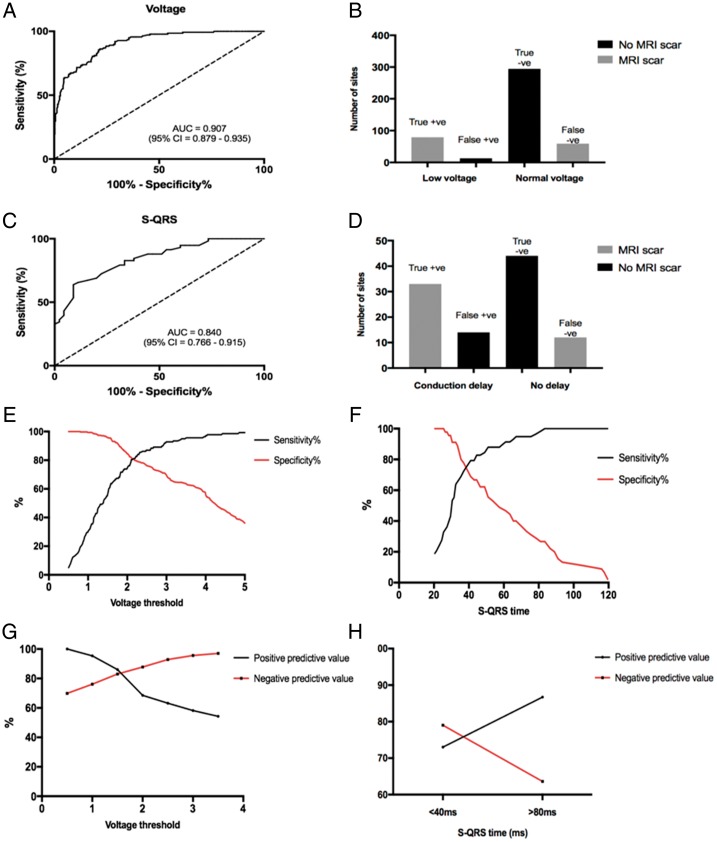
ROC curves (A and C) for prediction of LGE regions using voltage mapping and S-QRS. Frequency histograms (B and D) displaying the true positive, false positive, true negative, and false negative counts of voltage mapping and S-QRS measurements using the real-time MR-EP system to predict MRI-derived scar. Sensitivity, specificity, PPV, and NPV of measurements using the system using different normal voltage cut-offs and S-QRS times (E–H). LGE, late gadolinium enhancement; MR-EP, magnetic resonance imaging-guided electrophysiology; MRI, magnetic resonance imaging; NPV, negative predictive value; PPV, positive predictive value; ROC, receiver operator characteristic; S-QRS, stimulus-to-QRS.